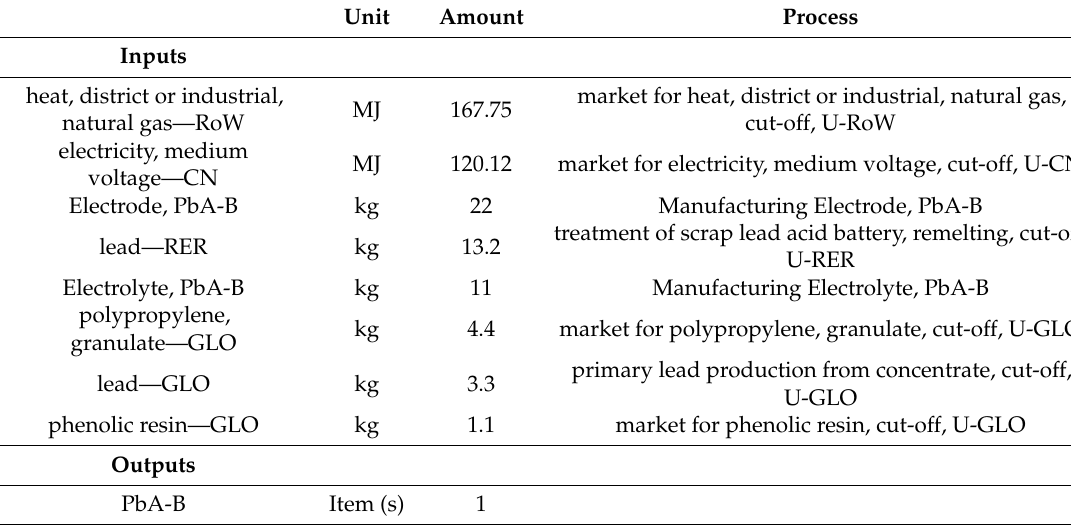
Table A18. Manufacturing, PbA-B.